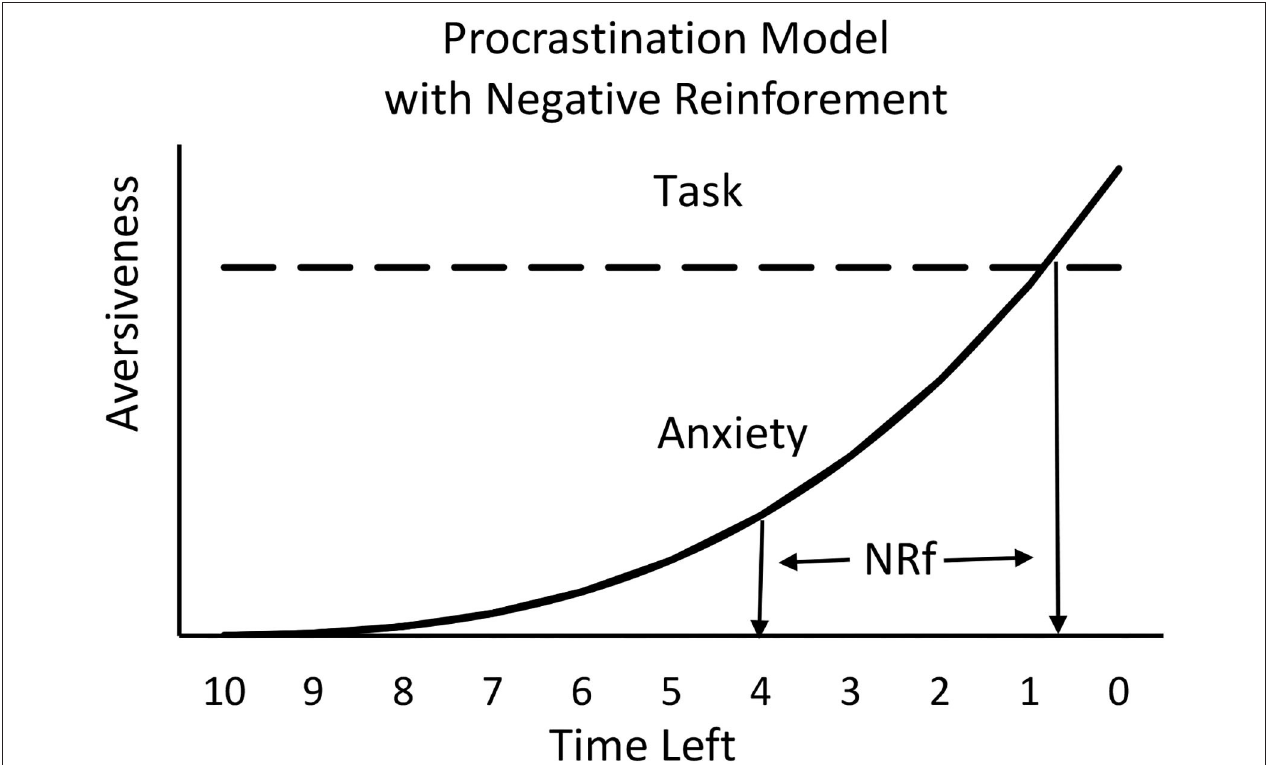
FIGURE 5 | Negative reinforcement (NRf) associated with the reduction in anxiety will depend on the amount of anxiety experienced and will increase as the time left approaches the deadline.